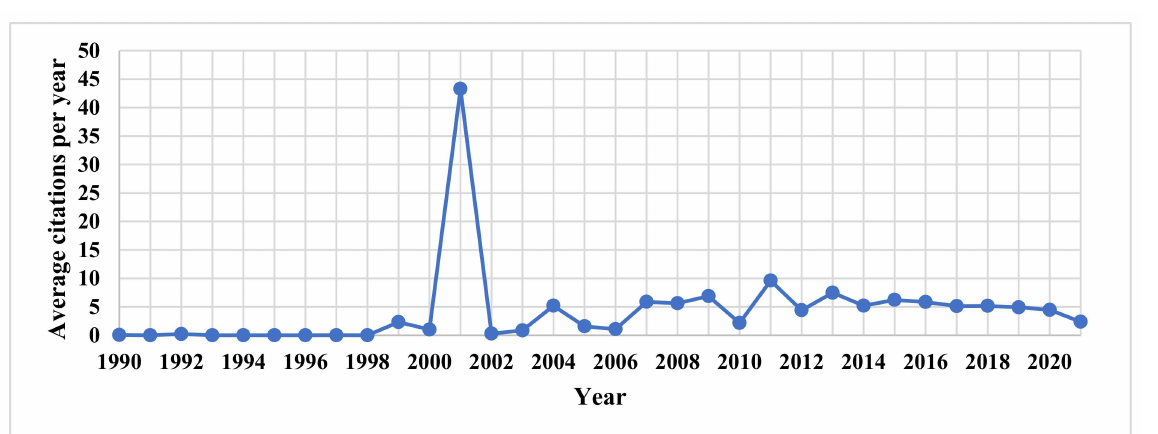
Figure 2. Average article citations per year. Source: own study using data from